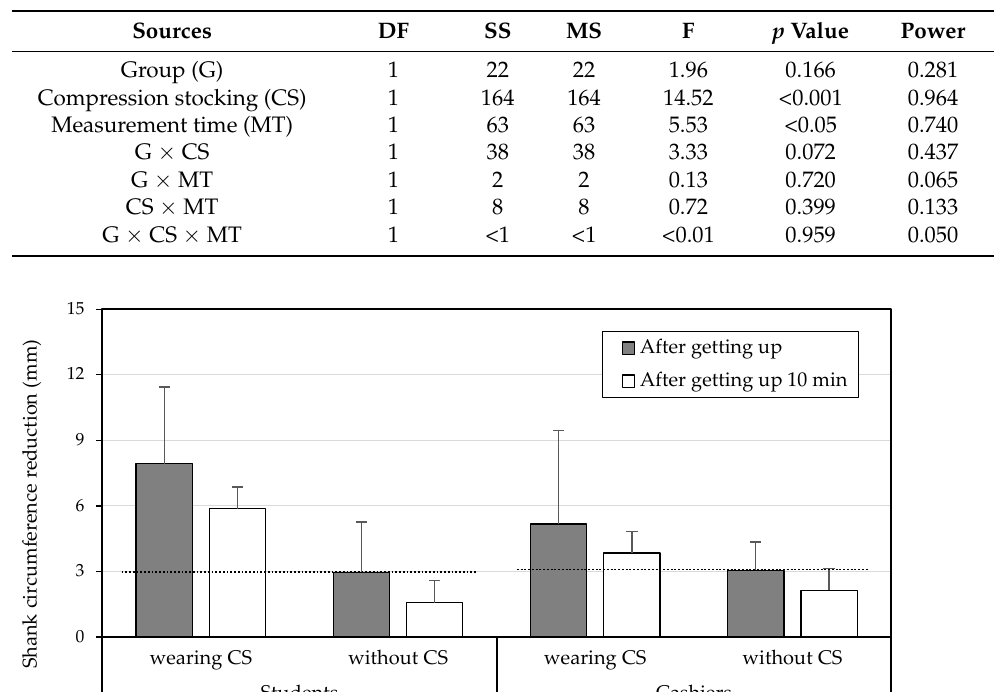
Figure 3. Shank circumference collected at varying time points under wearing and without compres- sion stockings (CSs) for two participant groups. Table 2. Main and interaction effects of shank circumference reduction obtained using three-way ANOVA.